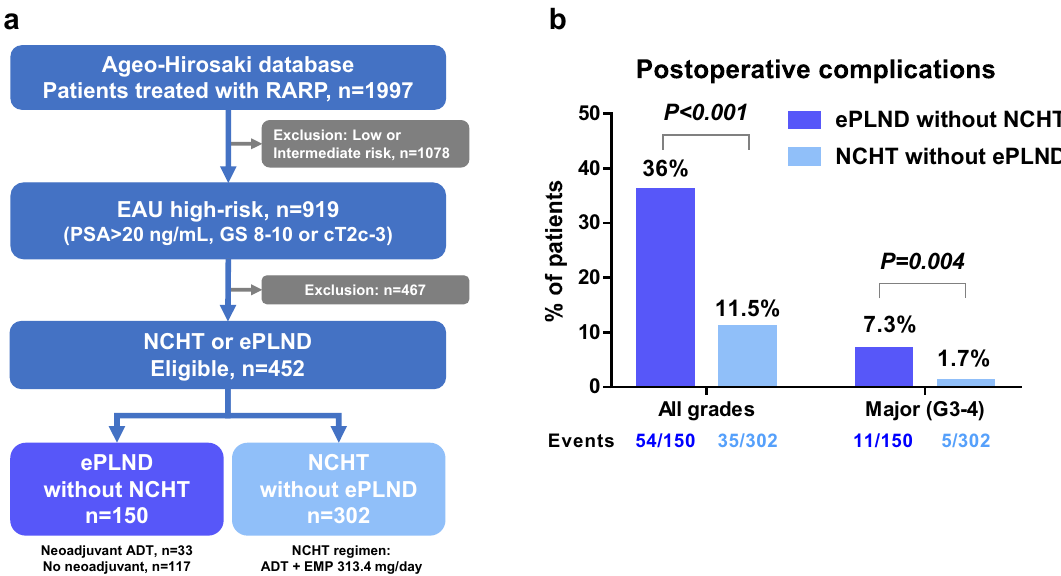
Figure 1. Patient selection and postoperative complications. ( a ) Patient selection. ( b ) Comparison of postoperative complications. ADT androgen deprivation therapy, EAU European Association of Urology, EMP estramustine phosphate, ePLND extended pelvic lymph-node dissection, GS Gleason score, NCHT neoadjuvant chemohormonal therapy, PSA prostate-specific antigen, RARP robot-assisted radical